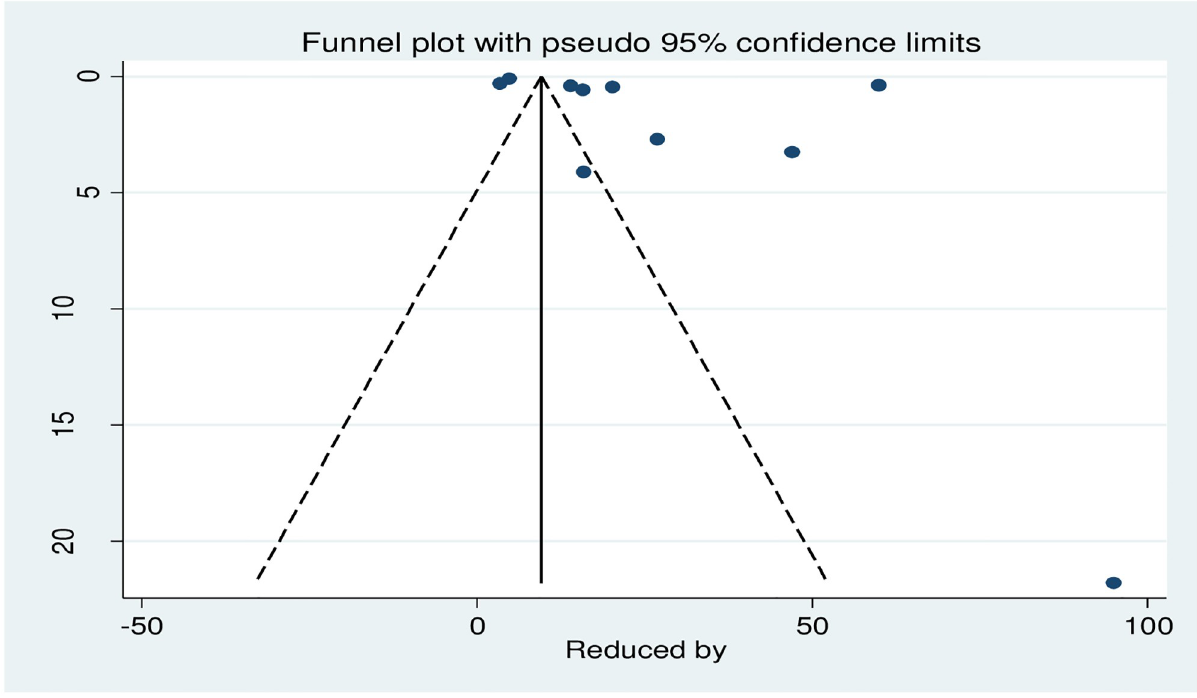
Fig 4. Funnel plot of all included